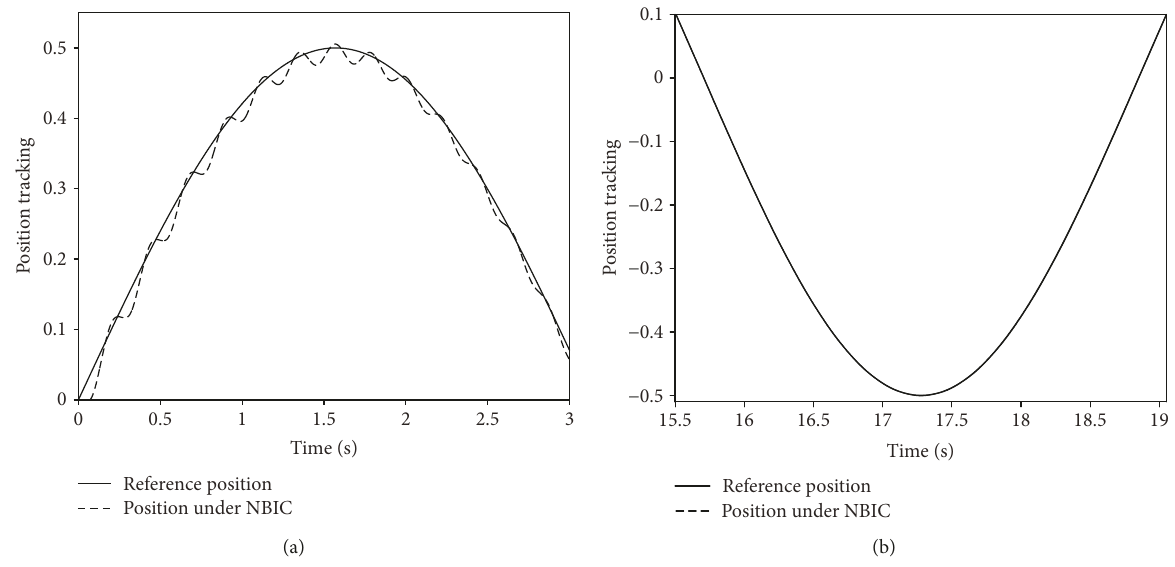
Figure 7: Partial enlargement of position tracking under the NBIC: (a) enlargement at the beginning and (b) enlargement at the